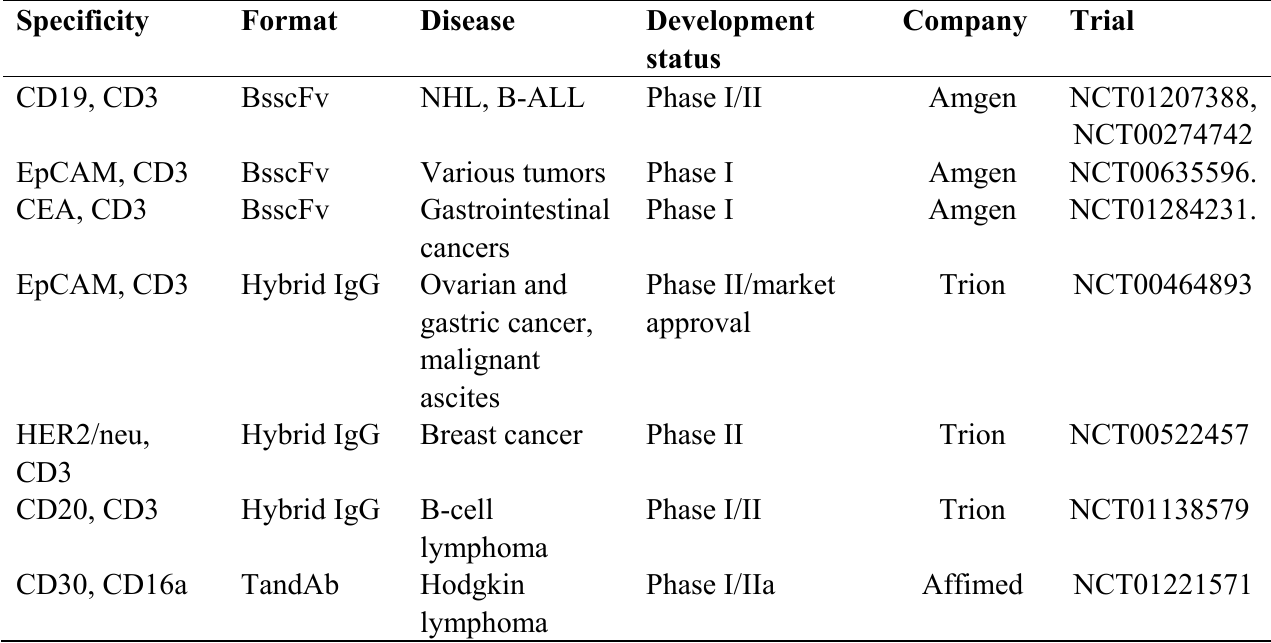
Table 2. NK- and T-cell recruiting recombinant antibodies in clinical